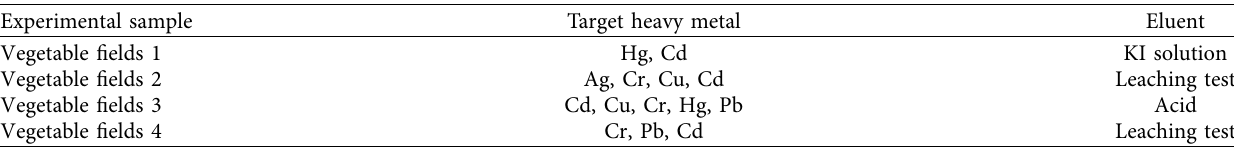
Table 4: The chemical leaching remediation of cadmium contaminated soil in greenhouse experiment in the United